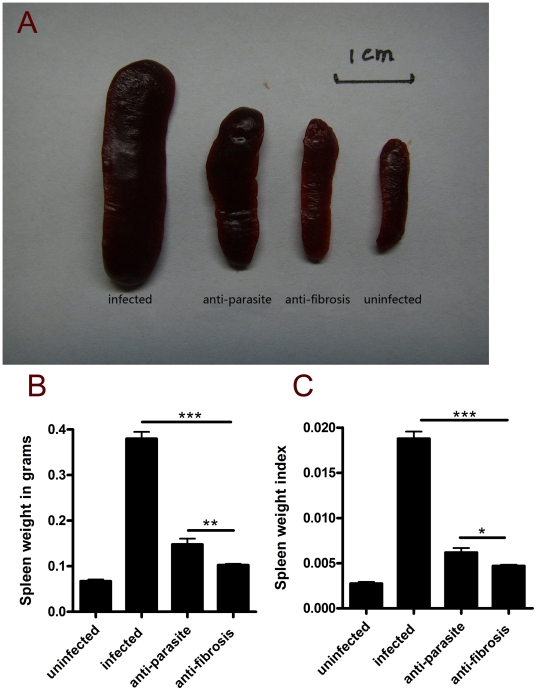
Anti-fibrosis treatment with prizaquantel reduced spleen weights in mice 8 weeks post infection with Schistosoma japonicum.(A) images of representative spleens in different groups. The bar is 1 cm. (B) Statistical analysis of spleen weights. (C) Spleen weight index (spleen weight/body weight). (* p<0.05, ** p<0.01, *** p<0.001).